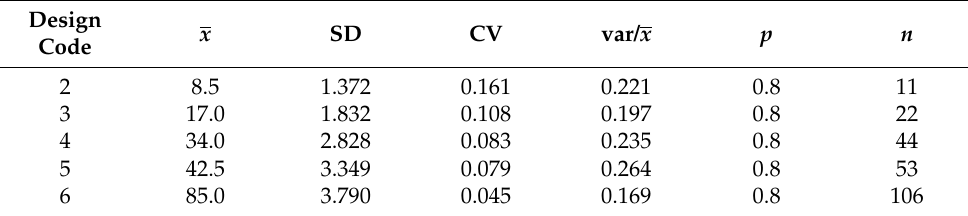
Table 4. Descriptive statistics and binomial distribution parameters for the plant population of different mosaic sizes. The number of the subplots is given in Table 3 for each design code. Design x Code